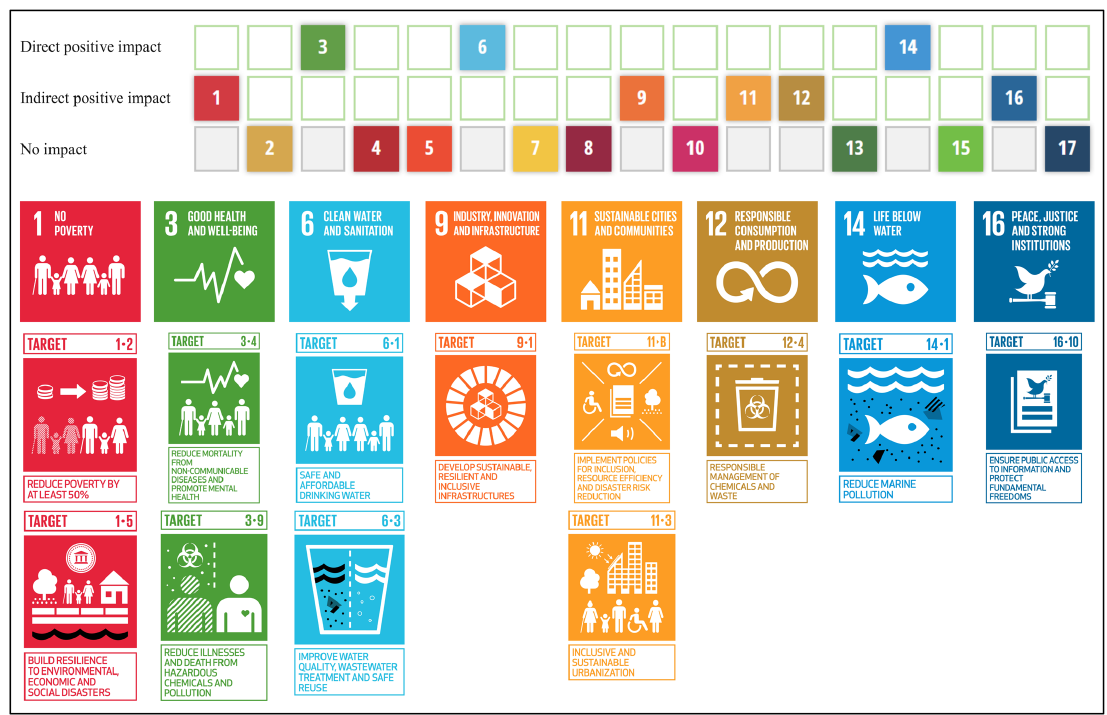
Figure 12. Map of SDGs impact assessment.